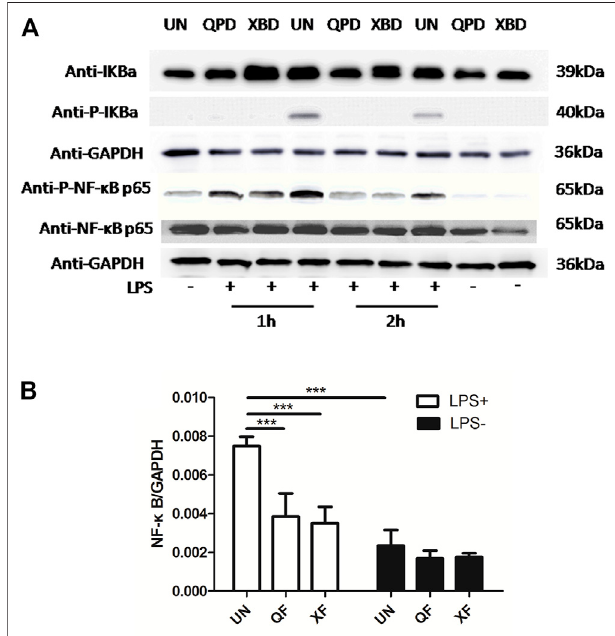
FIGURE 4 | QPD and XBD prevented LPS-induced activation of NF- κ B signaling pathway in THP-1 macrophages. M0 THP-1 macrophages were treated with QPD or XBD at indicated concentrations for 24 h and then stimulatedwithorwithout1 µg/mlLPSand20 ng/mlIFN- γ for1 hor2 h. Total proteins were extracted to detect I κ B α , phospho-I κ B α , NF- κ B p65, and phospho-NF- κ B p65 by western blot (A) . Total RNA was extracted to detect NF- κ B by RT-qPCR (B) . LPS+, treated with LPS and IFN- γ ; LPS-, treated without LPS and IFN- γ . *** p < 0 . 001.